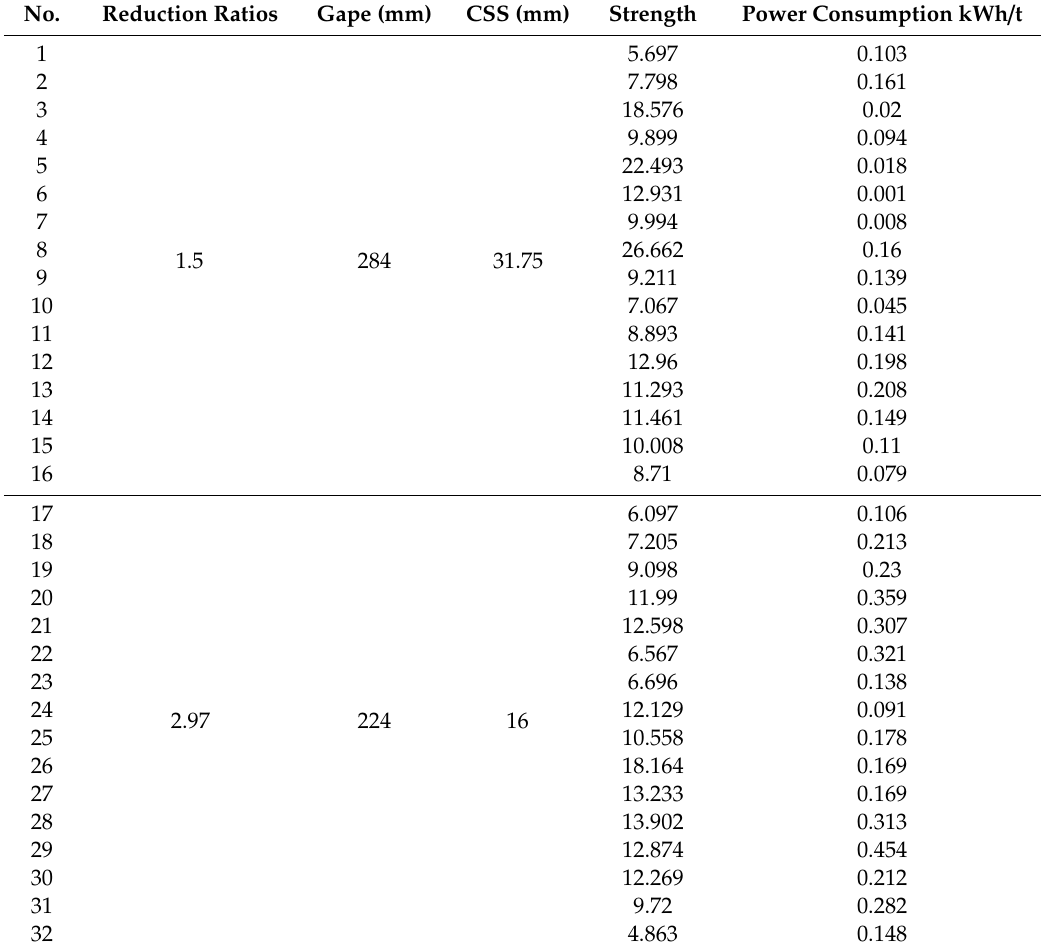
Table 1. Measured power consumption at di ff erent crushing